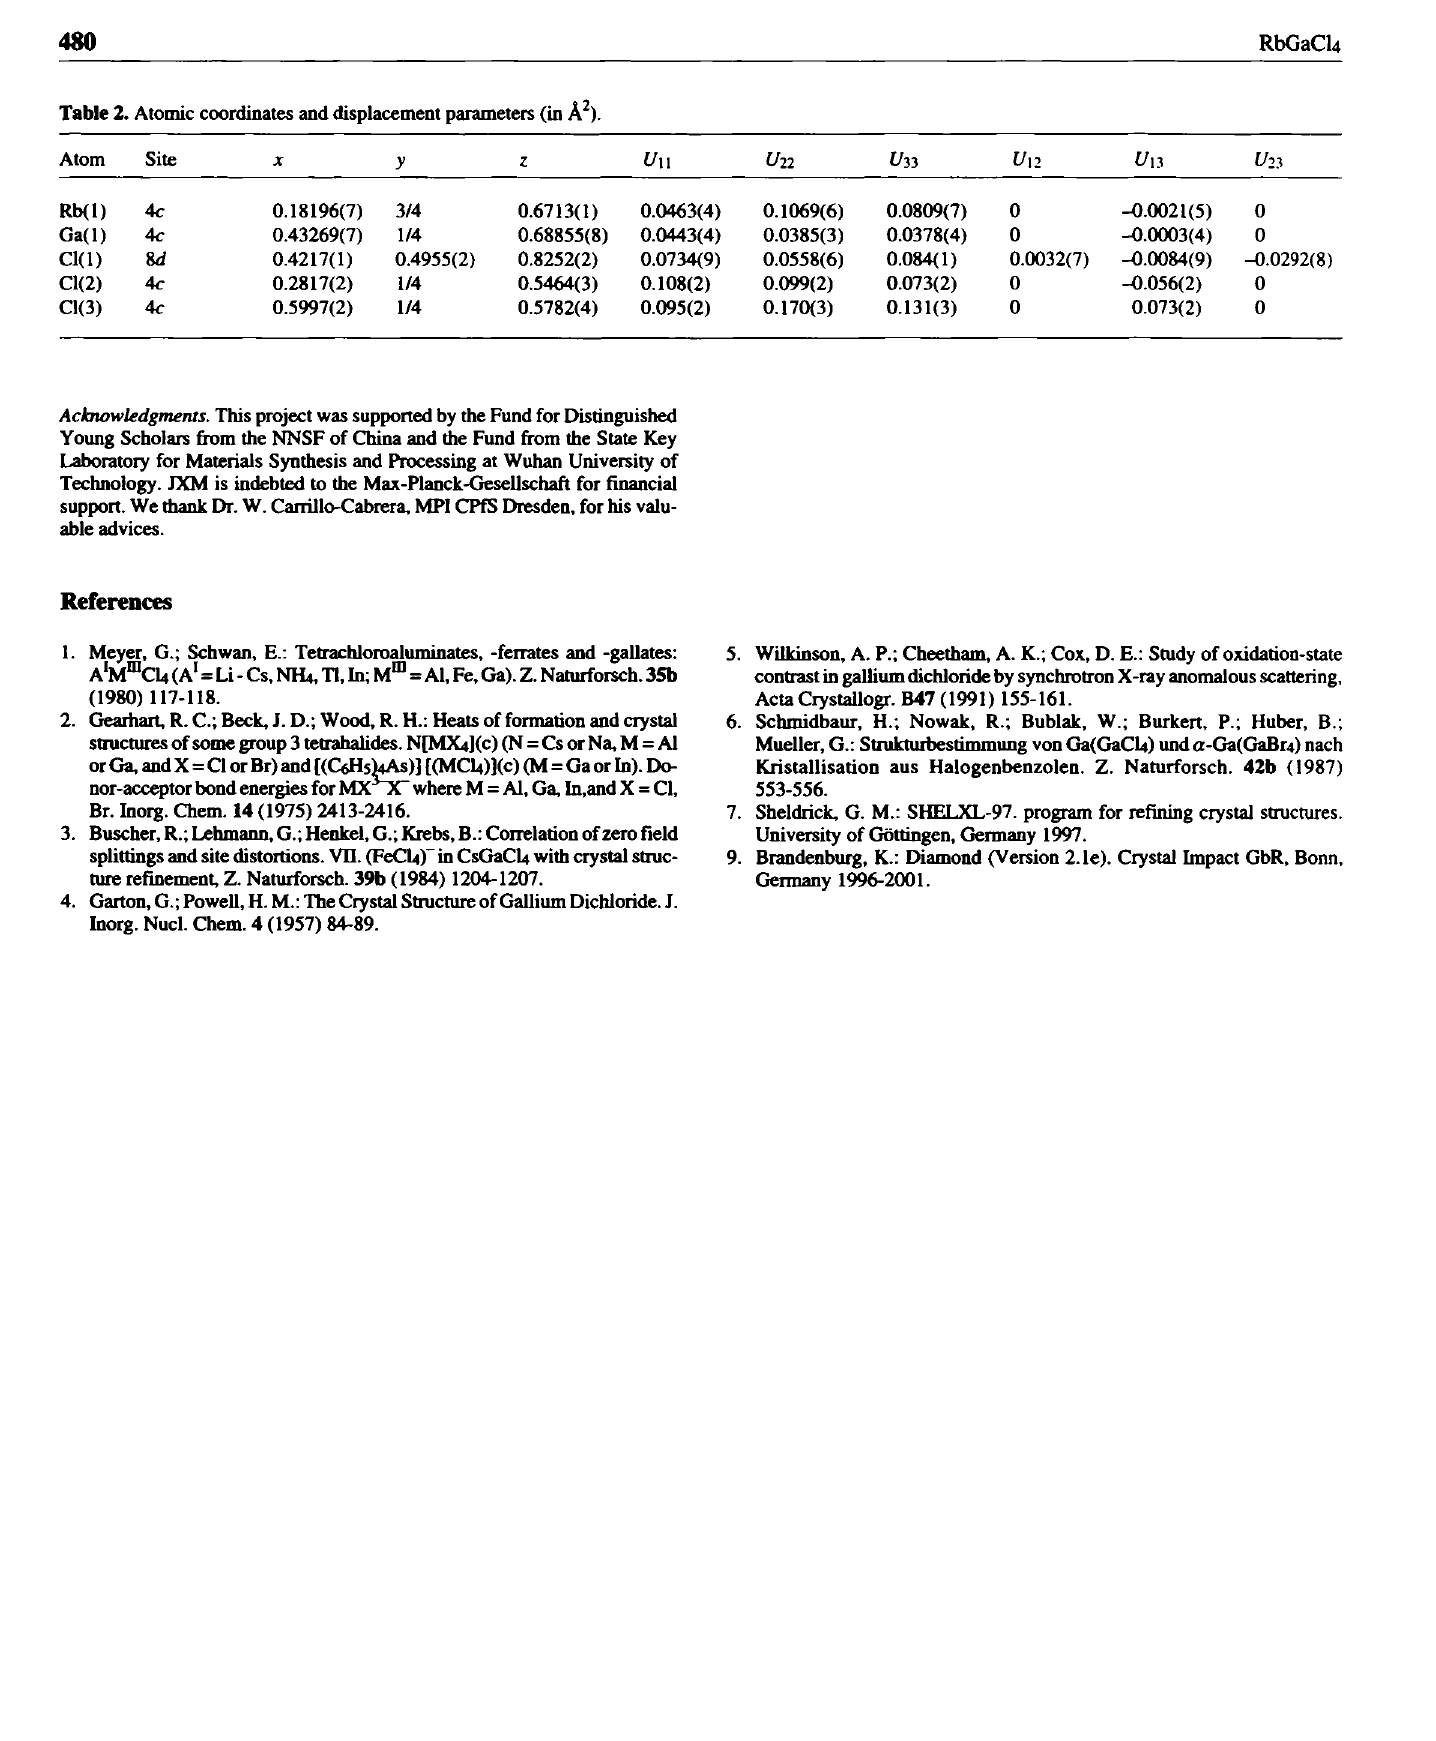
Table 2. Atomic coordinates and displacement parameters (in Â 2